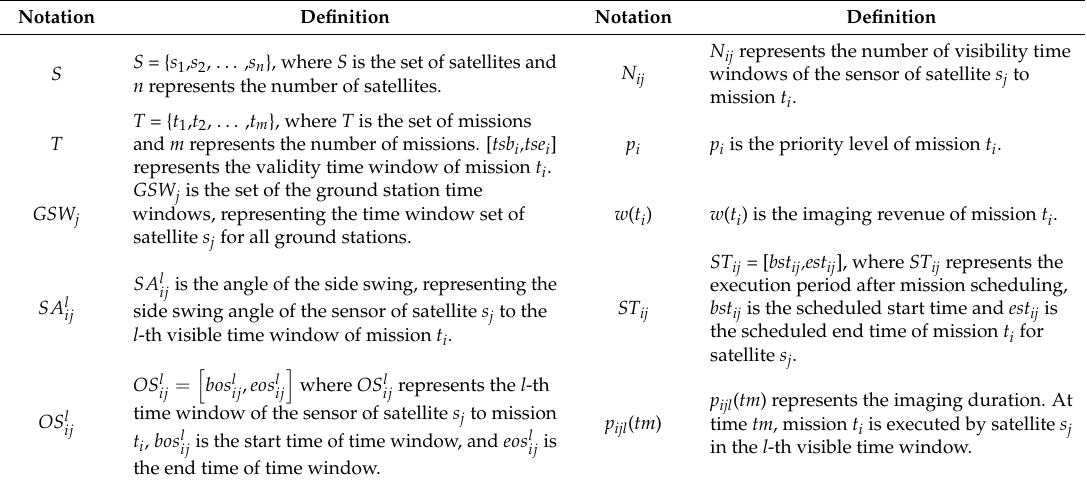
Table 2. Parameter and label definitions.